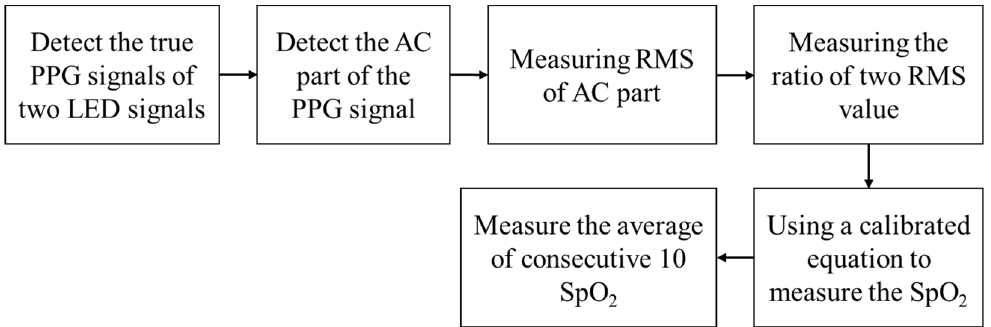
Figure 12. Block diagram of SpO 2 measurement. RMS, root mean square.